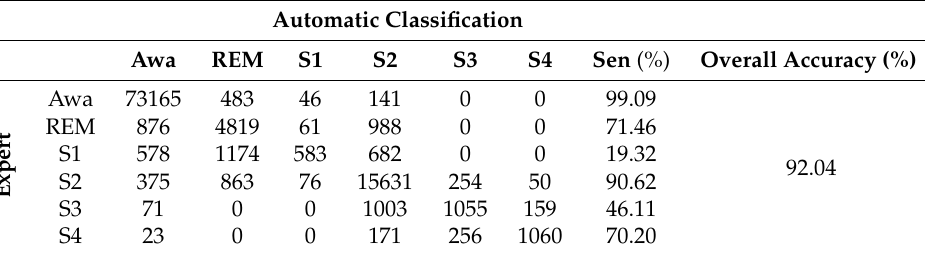
Table 27. the Confusion matrix of six classes sleep state classification on S-EDF database.